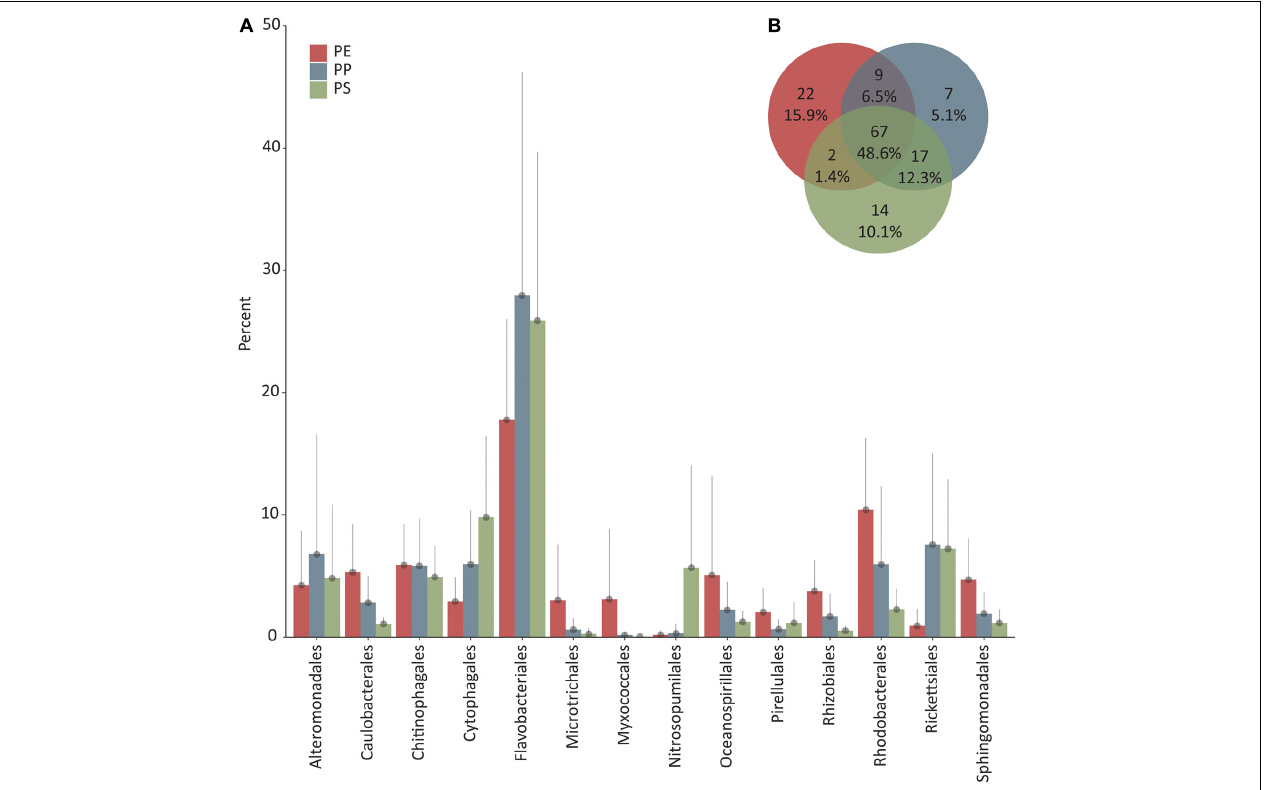
FIGURE 3 | (A) Top 10 dominant orders (percentage of total 16S rRNA gene read counts) per plastic type (PE, polyethylene; PP, polypropylene; PS, polystyrene). Error bars depict the standard deviation, and only the upper bar is shown. (B) Venn diagram showing the unique and shared number and percentage of the 100 most abundant orders of each plastic